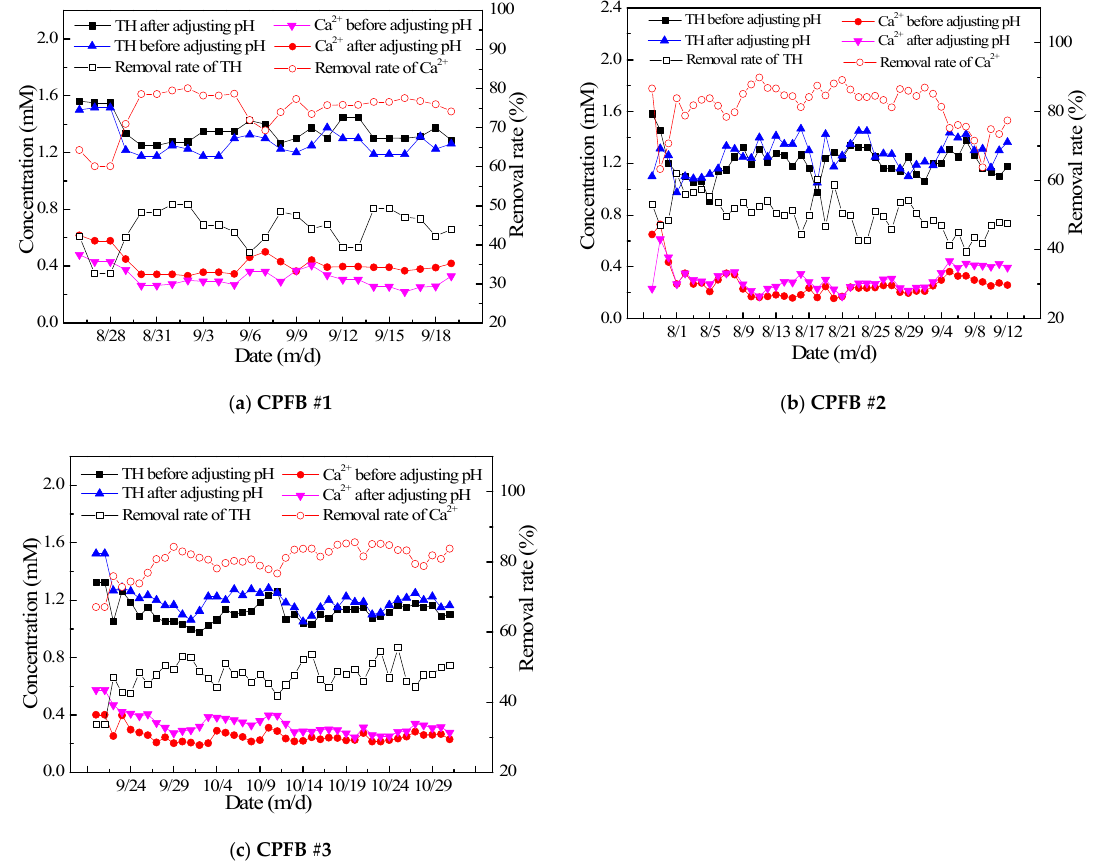
Figure 3. Hardness and Ca 2 + ion removal performance of circulating pellet fluidized beds (CPFBs). (( a )-hardness and Ca 2 + ion removal performance of circulating pellet fluidized bed(CPFB) #1 at di ff erent dates; ( b )-hardness and Ca 2 + ion removal performance of circulating pellet fluidized bed(CPFB) #2 at di ff erent dates; ( c )-hardness and Ca 2 + ion removal performance of circulating pellet fluidized bed(CPFB) #3 at di ff erent